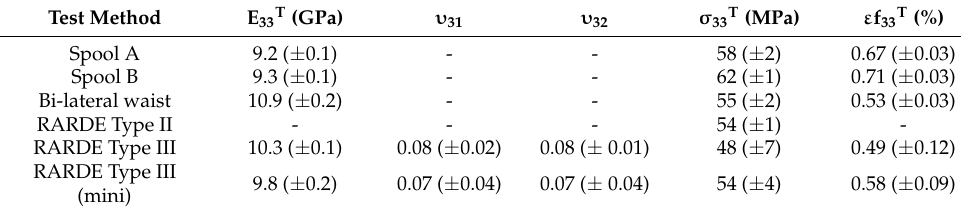
Table 6. T-T tensile properties determined from testing of direct